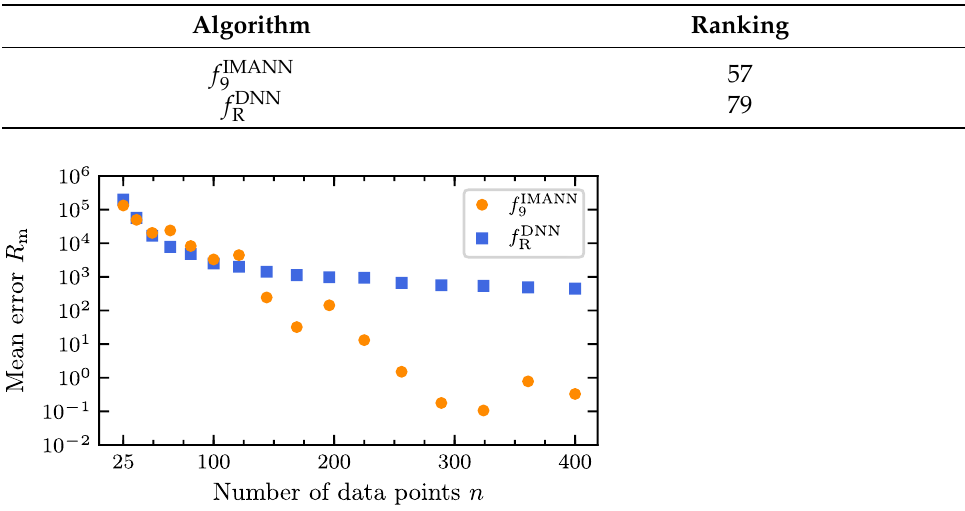
Table 5. Ranks of the algorithms (Wilcoxon).